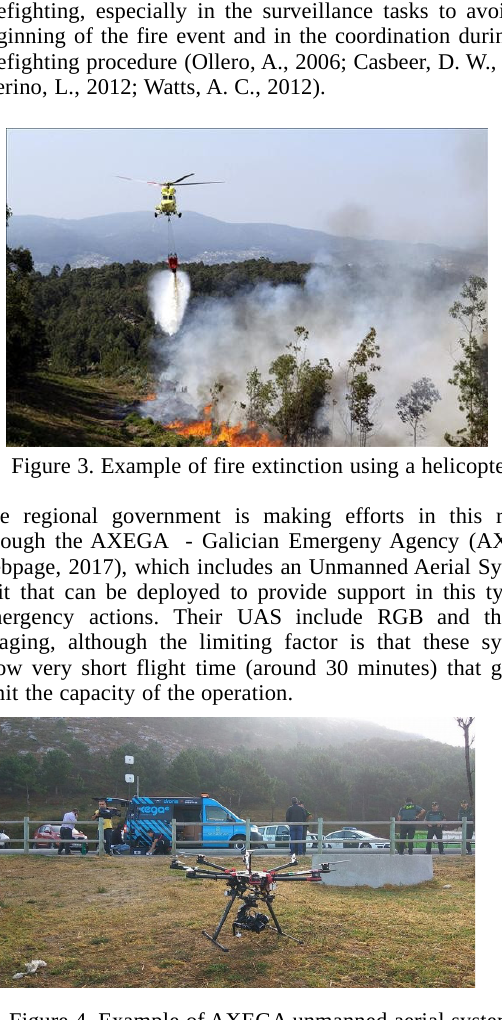
Figure 4. Example of AXEGA unmanned aerial system.